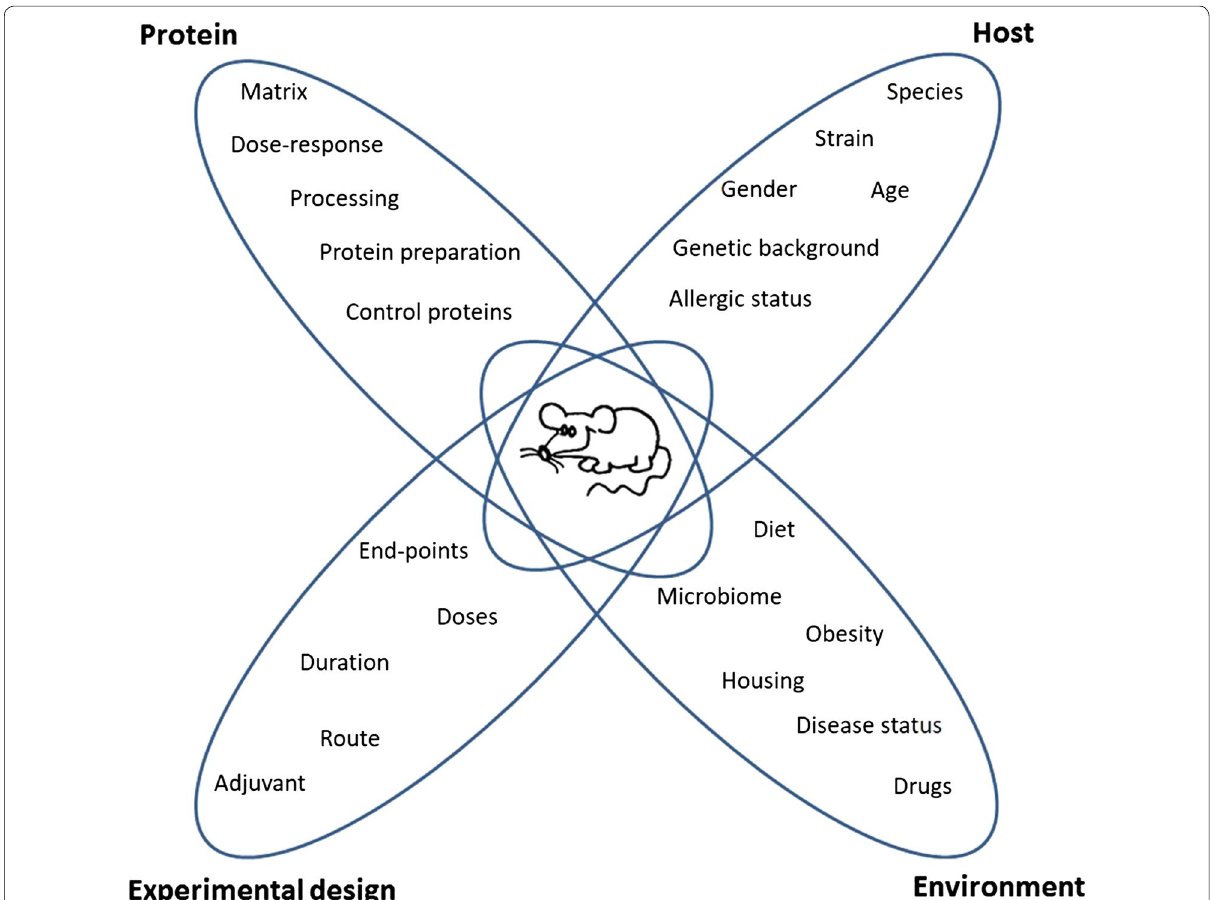
Fig. 2 Parameters to consider when designing animal models for assessing the sensitising capacity of food allergens. These parameters are related to either the protein, host, experimental design or the environment Modified from Bøgh et al. Clin Transl Allergy 2016